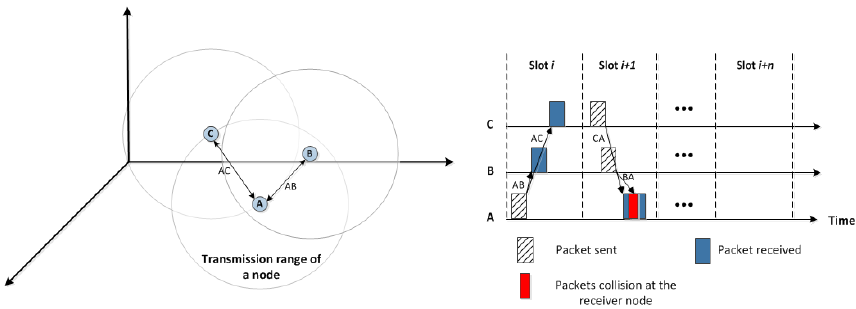
Figure 2. An example of hidden terminal problems.